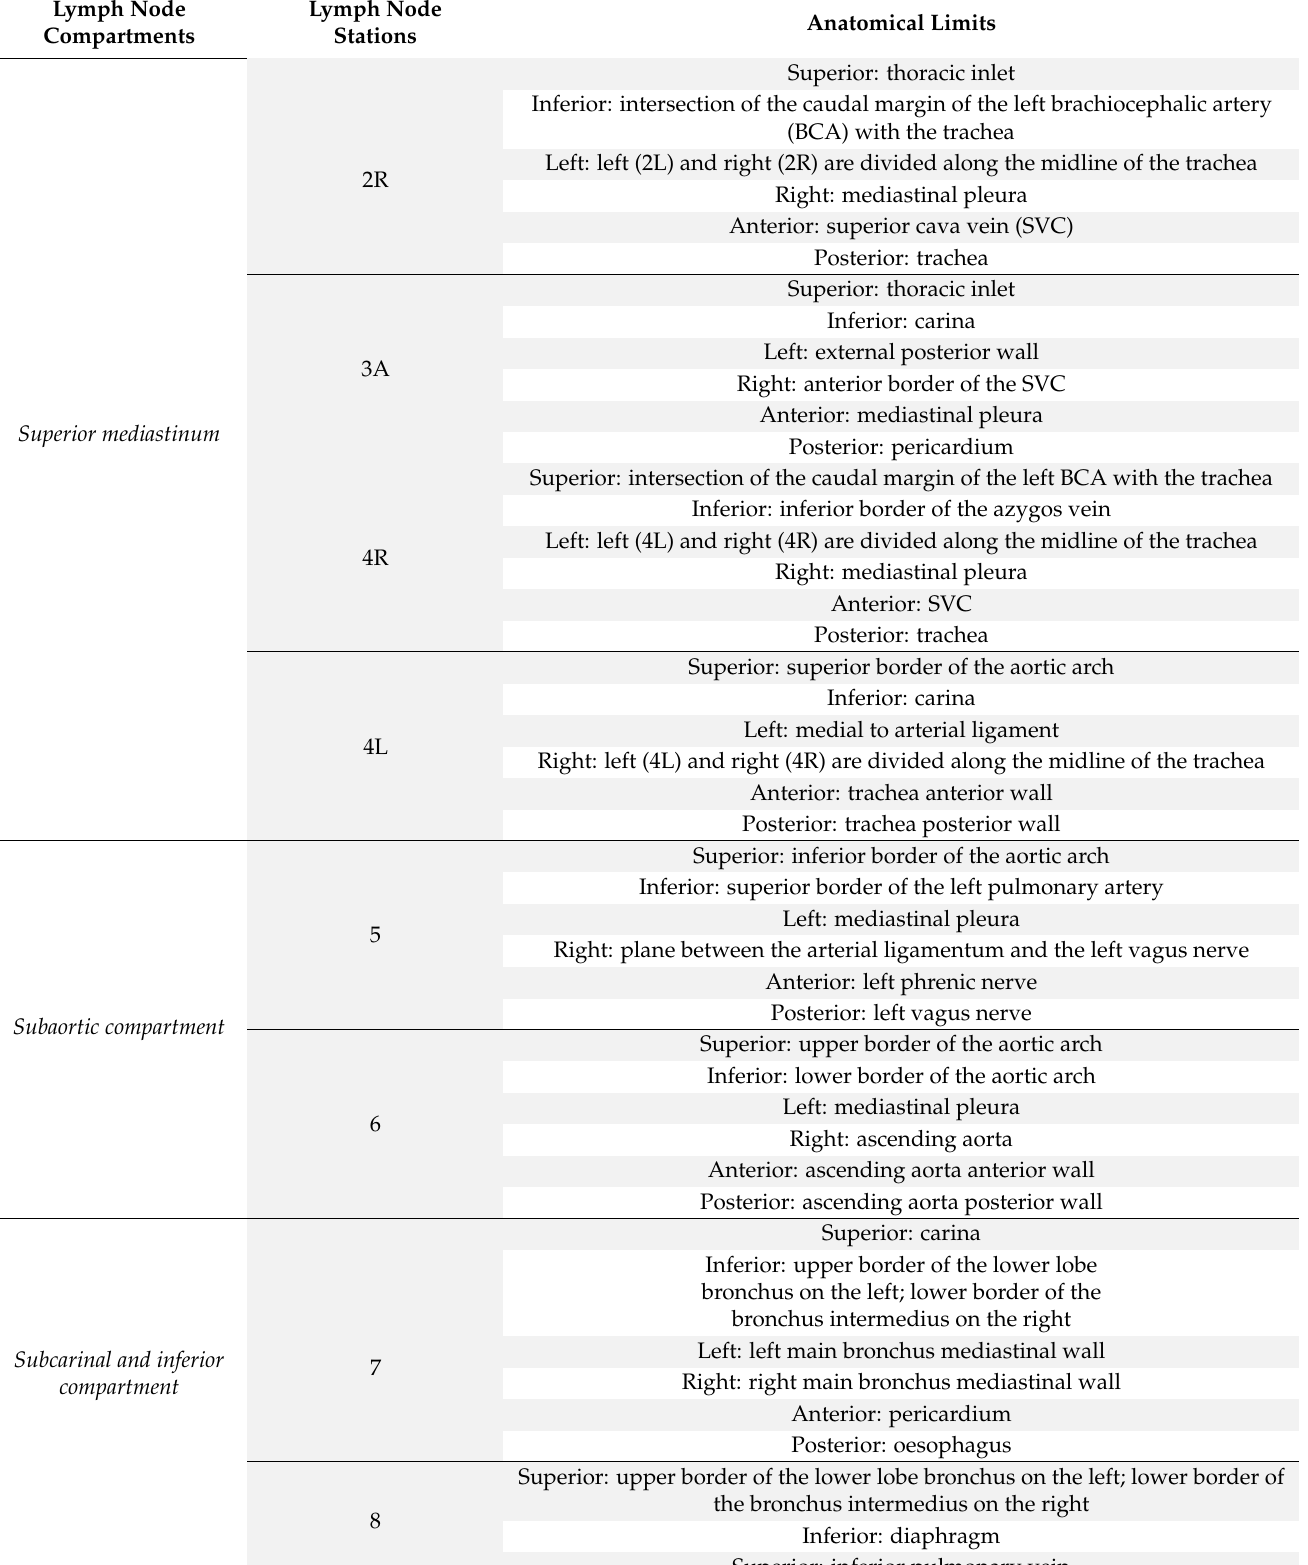
Table 2. Lymph node station